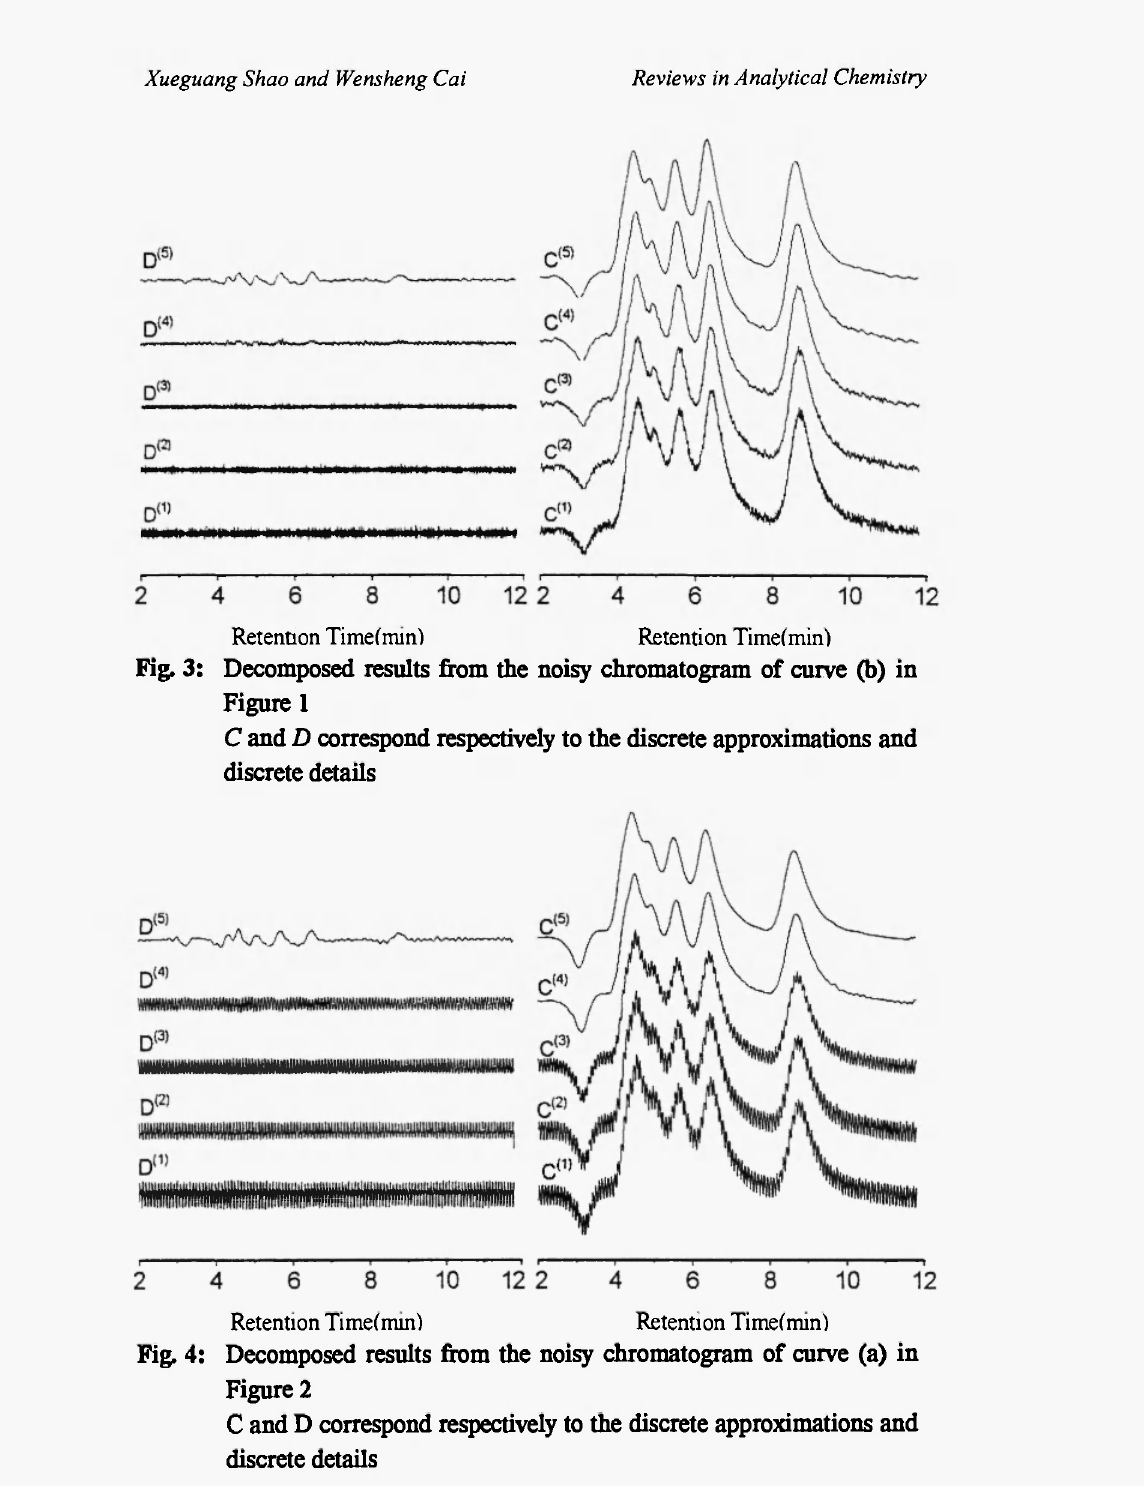
Fig. 4: Decomposed results from the noisy chromatogram of curve (a) in Figure 2 C and D correspond respectively to the discrete approximations and discrete